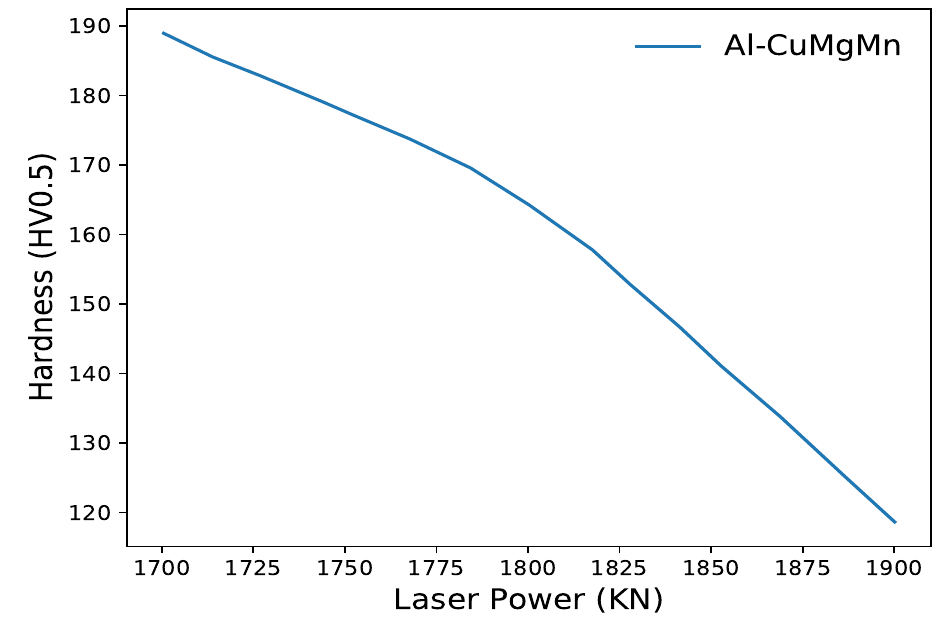
Figure 7. Micro-hardness of laser alloy surface modified at different laser powers with laser spot diameter of 5.8 mm and laser scan speed of 5 mm/s